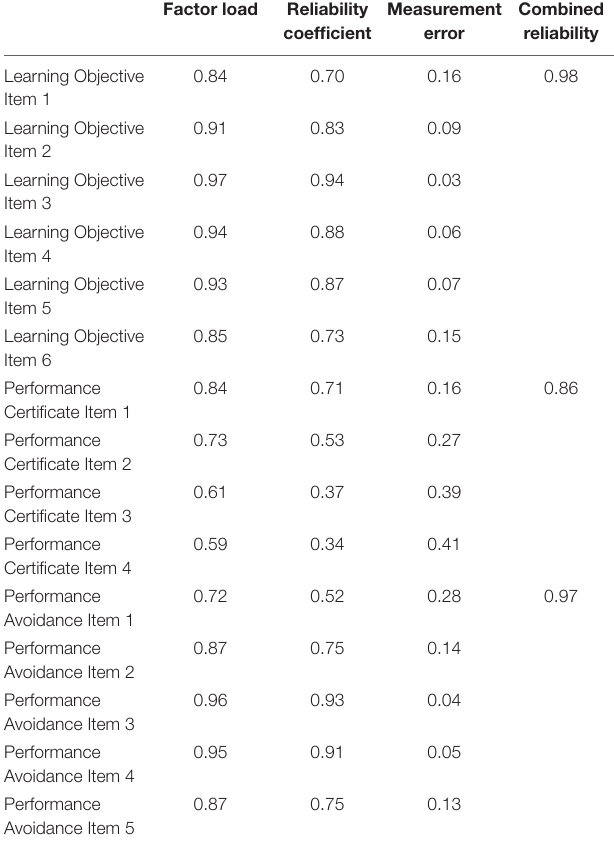
TABLE 3 | Result of confirmatory factor analysis of variable aggregation